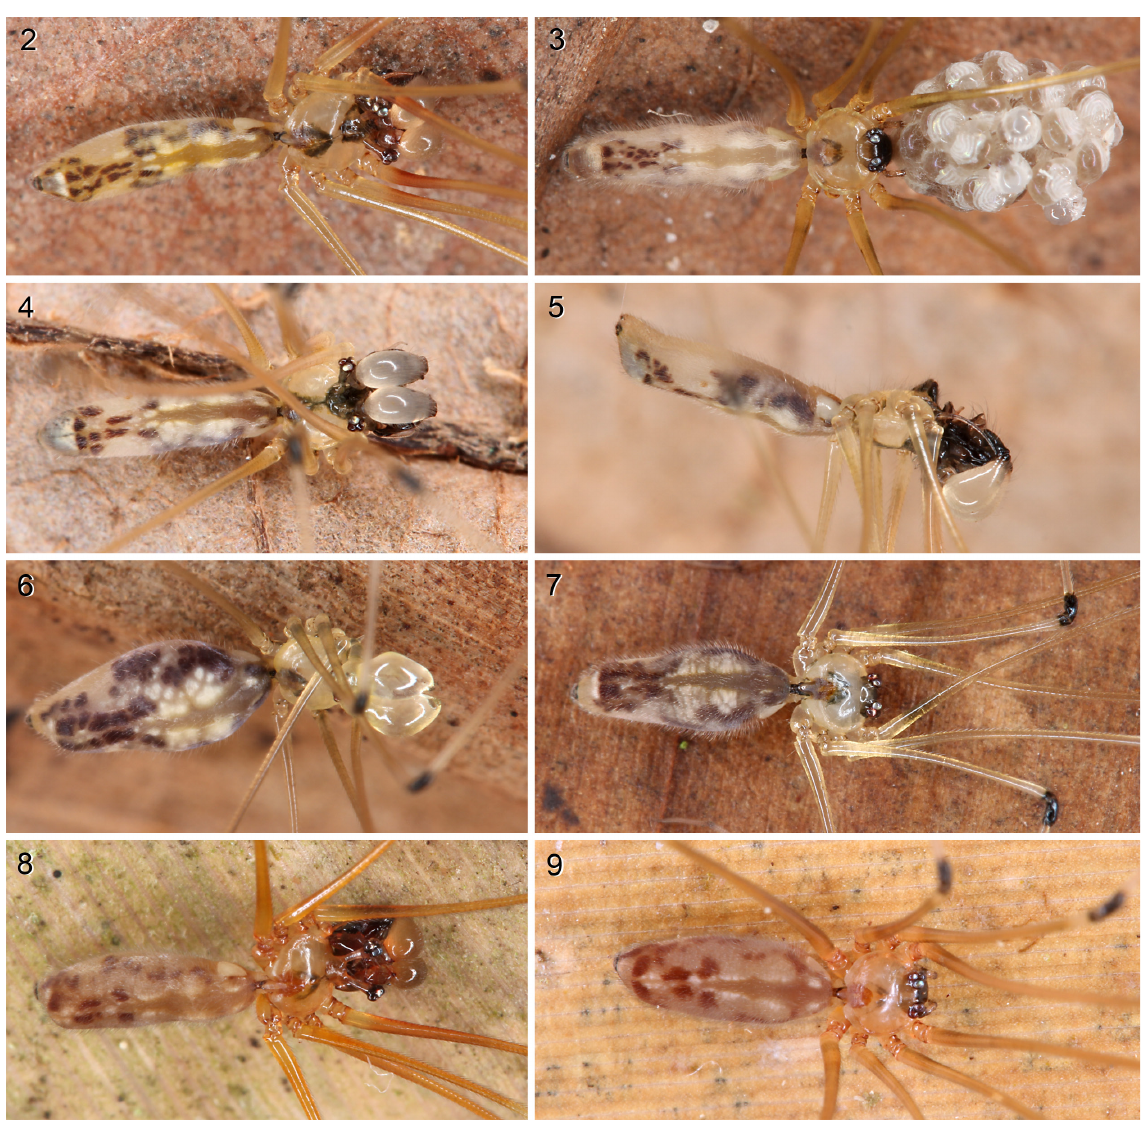
Figs 2–9. Live specimens. 2–3 . Pholcus phui Huber, 2011, Hala Bala, ♂ and ♀ with